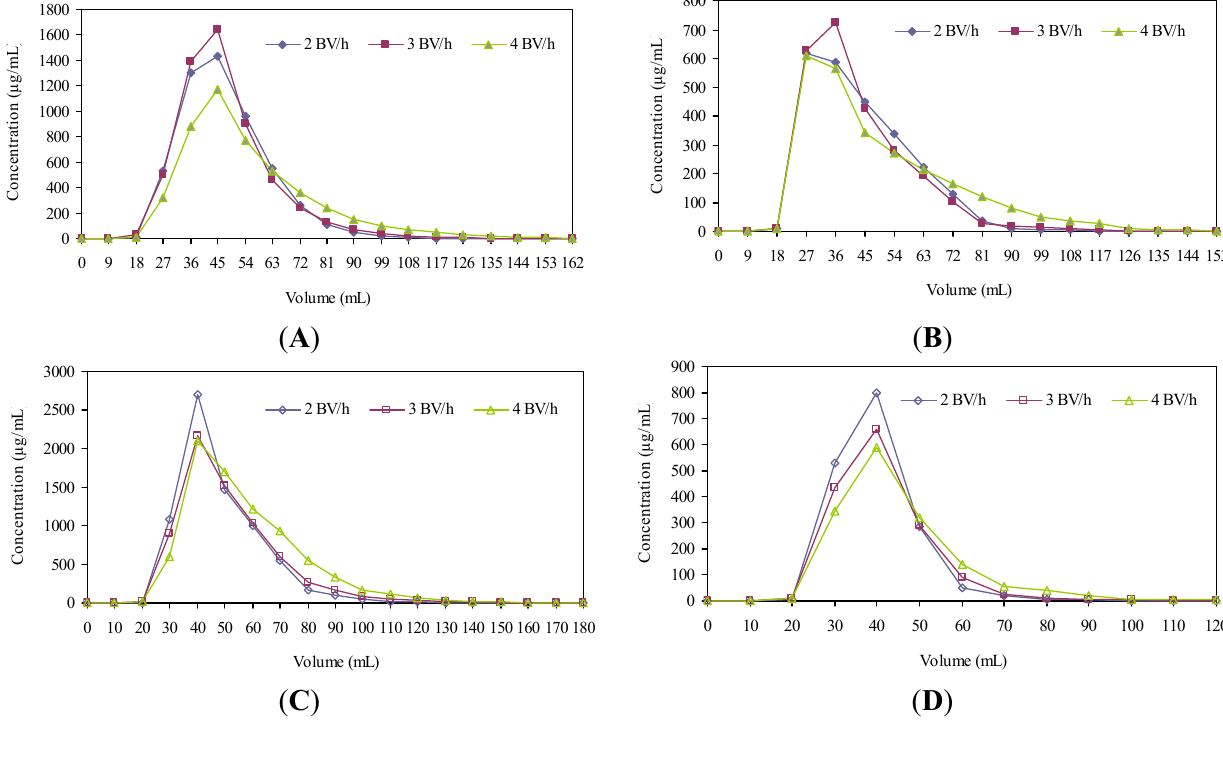
Figure 4. Dynamic desorption curves of ustiloxin A on the column packed with resin SP207 ( A ), ustiloxin B on the column packed with resin SP207 ( B ), ustiloxin A on the column packed with resin SP700 ( C ), and ustiloxin B on the column packed with resin SP700 ( D